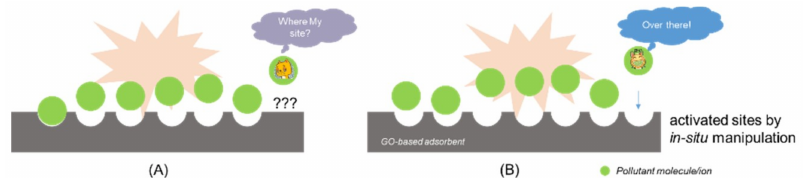
Figure 8. ( A ) The schematic diagram of conventional one–step adsorption; ( B ) Enhanced two-step adsorption: simultaneously generate new sites from inactive structures for enhanced capacity.